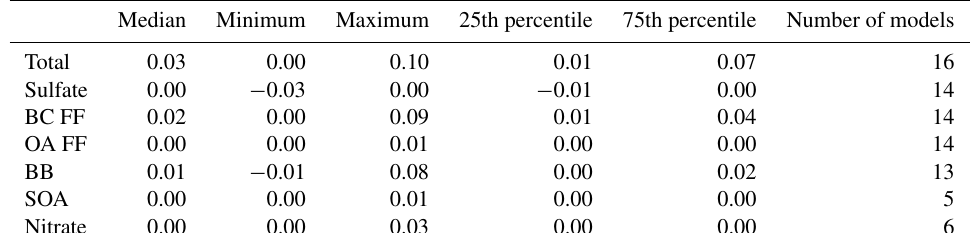
Table 6. As Table 5, but averaged over the Antarctic region (70–90 ◦ S).